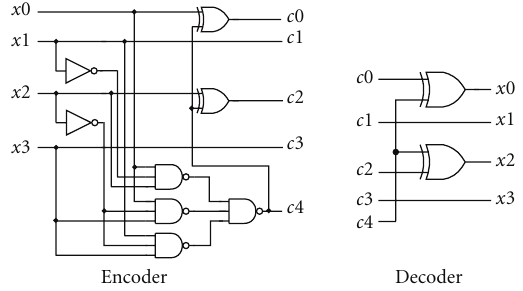
Figure 9: The encoder and decoder of green bus coding